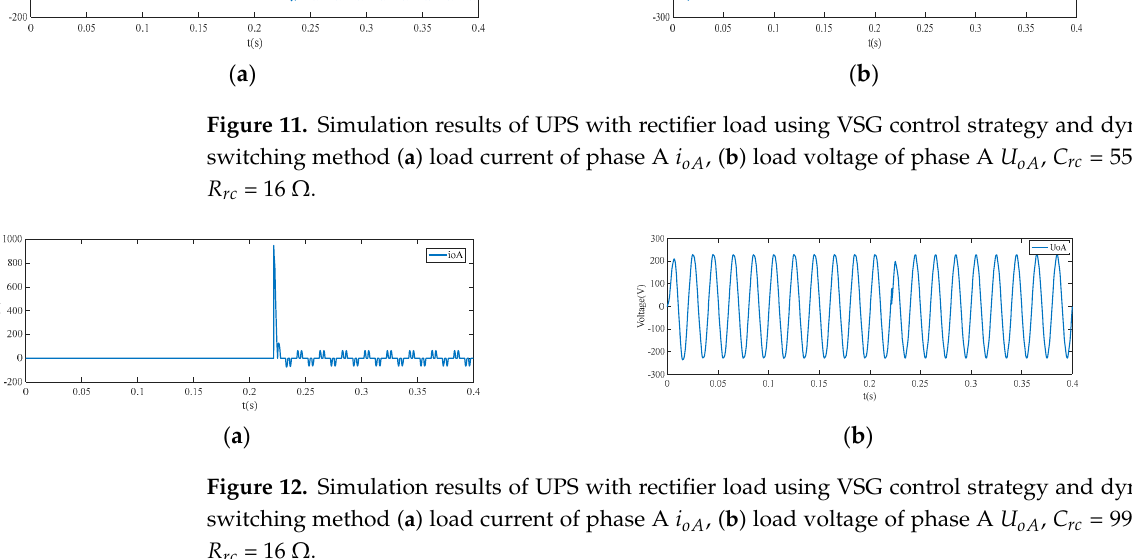
Figure 12. Simulation results of UPS with rectifier load using VSG control strategy and dynamic switching method ( a ) load current of phase A 𝑖 (cid:3042)(cid:3002) , ( b ) load voltage of phase A 𝑈 (cid:3042)(cid:3002) , 𝐶 (cid:3045)(cid:3030) = 9900 µF, 𝑅 (cid:3045)(cid:3030) = 16 Ω .